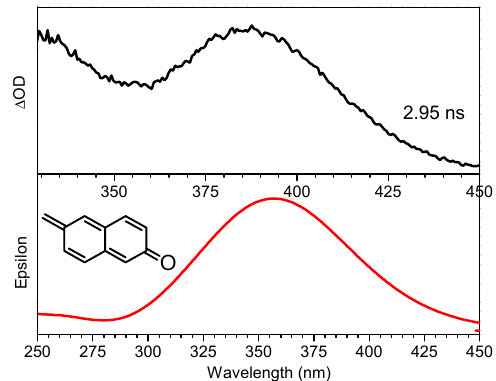
Figure 3. The QMP-b fs-TA spectrum of acquired subsequent to 266 nm photolysis in MeCN:H 2 O (1:1, pH = 12) at 2.95 ns (top) compared to the QM intermediate computed TD-B3LYP/6-311G(d,p) spectrum.